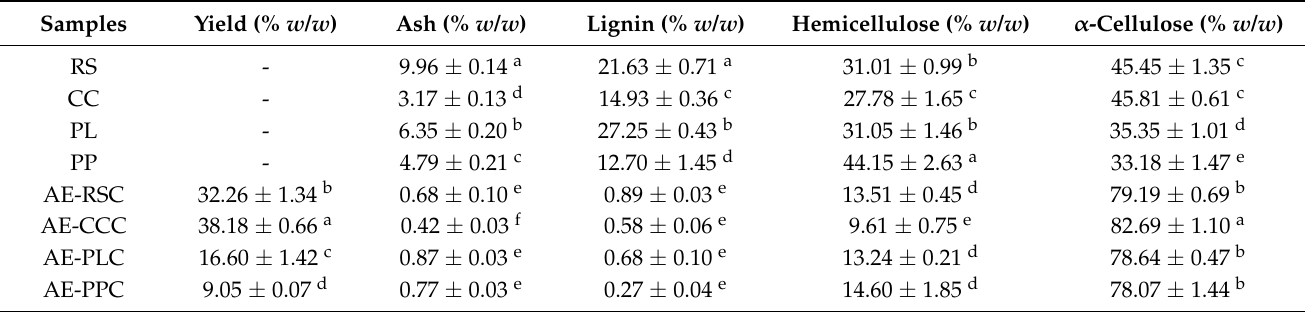
Table 1. Physico-chemical compositions of cellulose extracted from agricultural waste without and with alkaline extraction